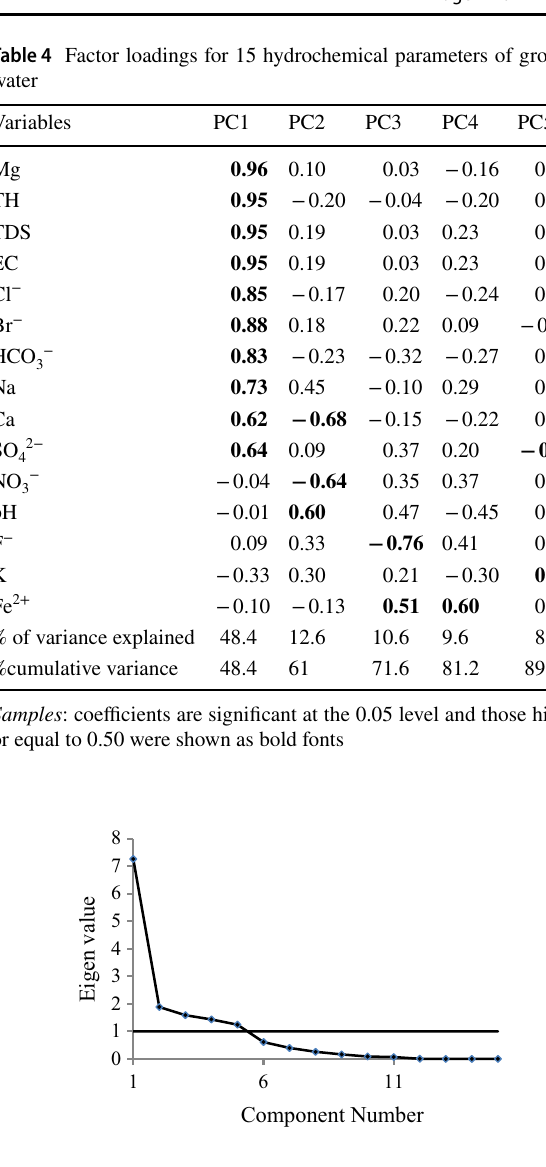
Fig. 5 PCA scree plot of the Eigenvalues for the dataset of groundwa- ter